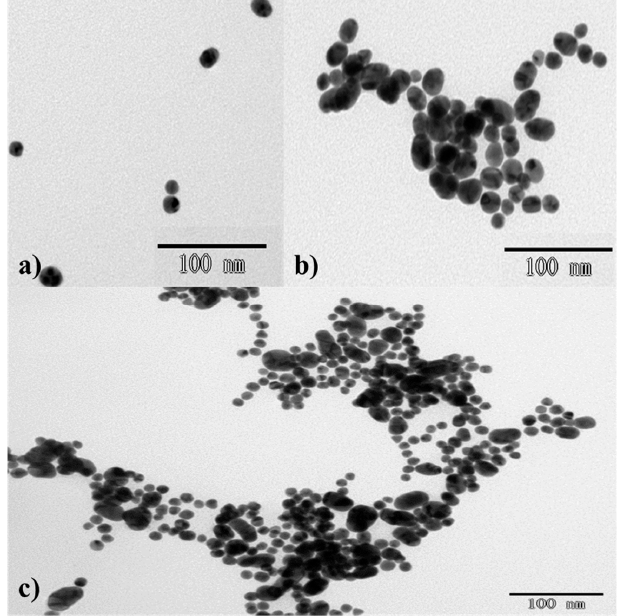
Figure 2. TEM images of ( a ) AuNPs, ( b ) AuNPS with 2.0 mg/L chlorsulfuron and 20 mg/L chlorsulfuron, ( c ) AuNPS with 20 mg/L acetamiprid.